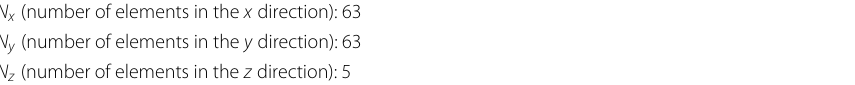
Table 6 Refined 3D FEM considered for defining the reference solution N x (number of elements in the x direction): 63 N y (number of elements in the y direction): 63 N z (number of elements in the z direction):